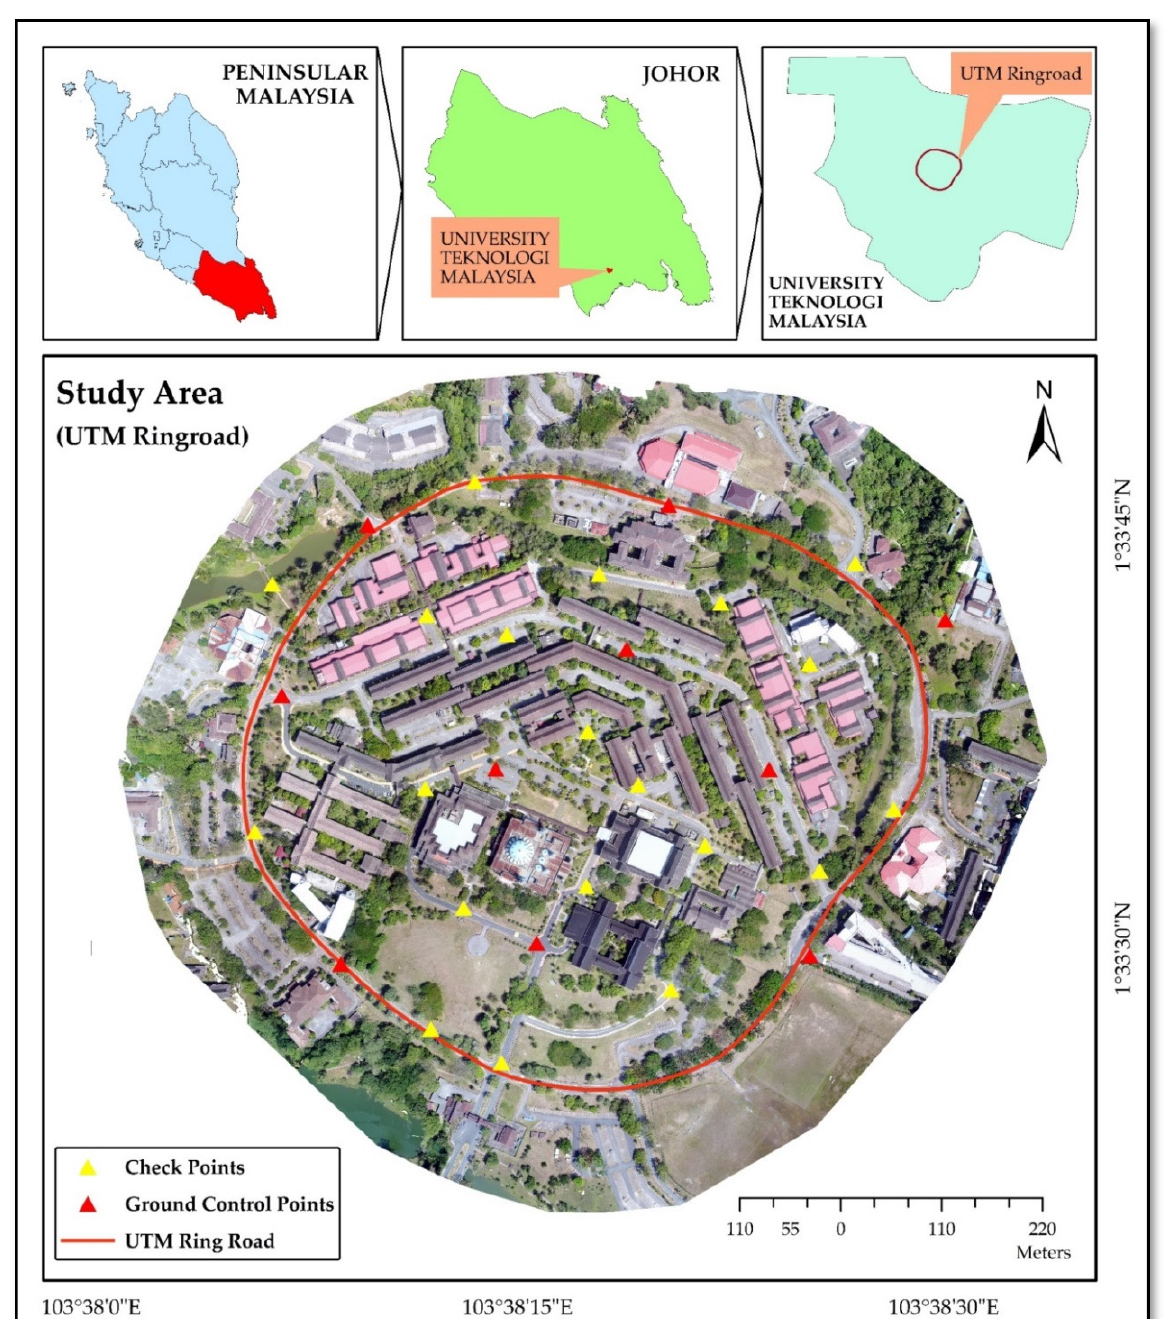
Figure 1. Study area with location of ground control points (GCPs) and check points (CPs).